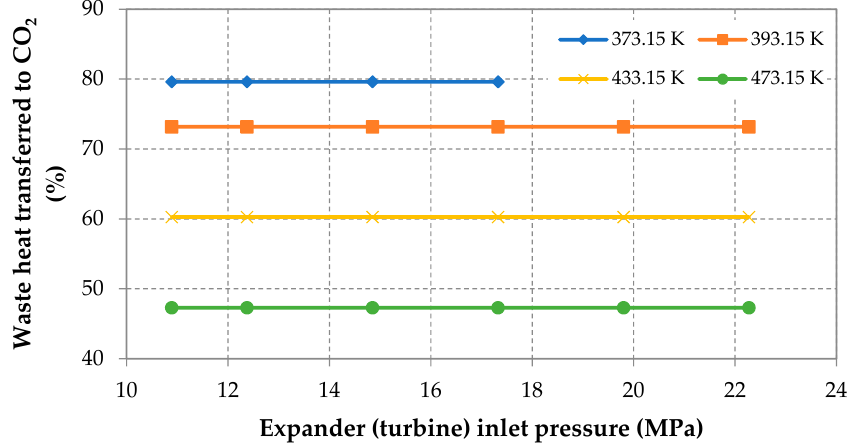
Figure 5. Relationship between turbine inlet temperature and percent of waste heat transferred to CO 2 for the di ff erent exhaust gas temperatures at the heat exchanger outlet.